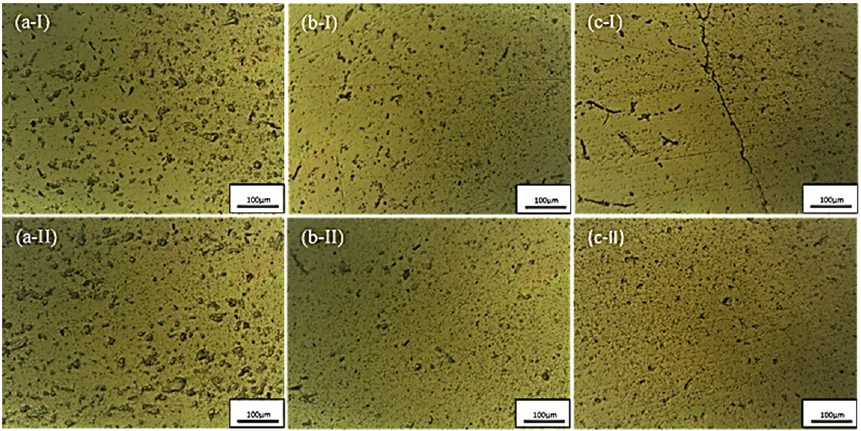
Figure 23. Microstructure of FSPed surface using CTH tool at 1200 rpm for feed rates of, ( a ) 20 mm/min, ( b ) 25 mm/min, and ( c ) 30 mm/min of different regions, whereby (a-I–c-I) is HAZ-SZ boundary and (a-II–c-II) is the SZ.